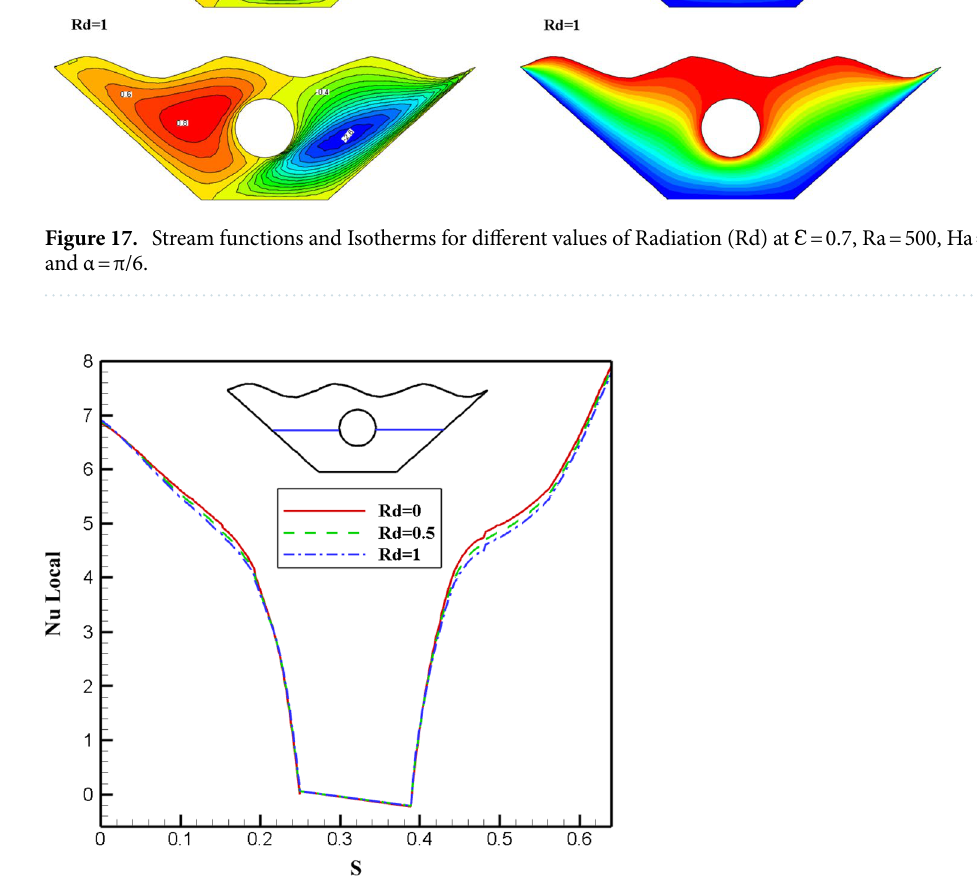
Figure 18. Local Nu number plot for different Radiation